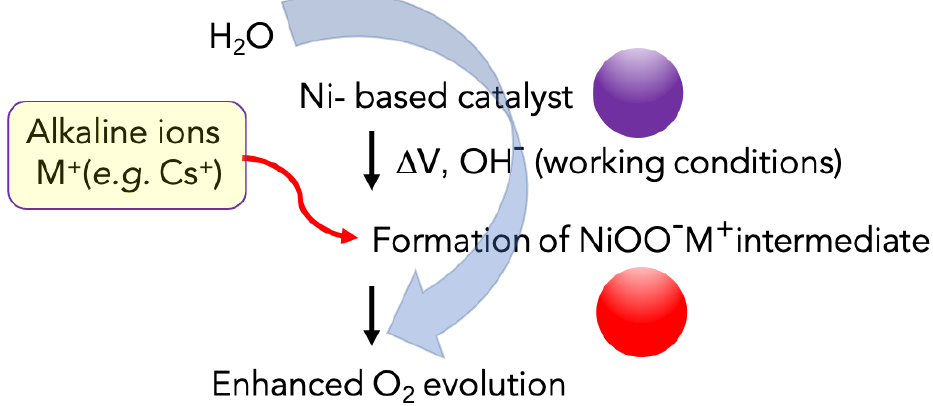
Figure 7. Example of manipulation of local microenvironment to improve OER. Enhancement of